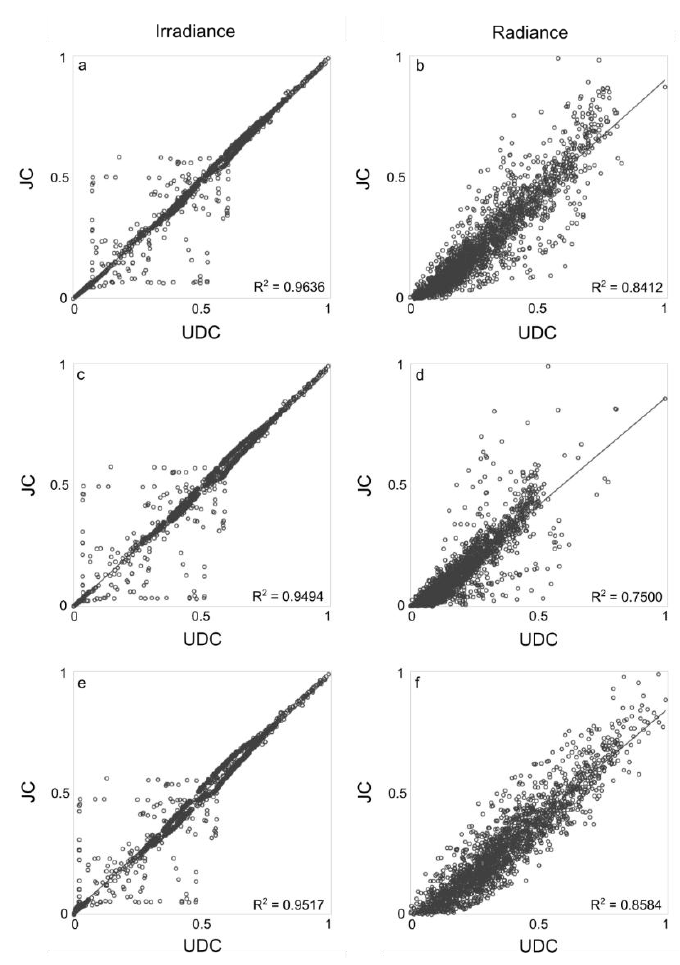
Figure 4. Scatterplots of green ( a , b ), red ( c , d ) and NIR ( e , f ) irradiance and radiance measured with UDC and JC. The linear regression lines are in solid.